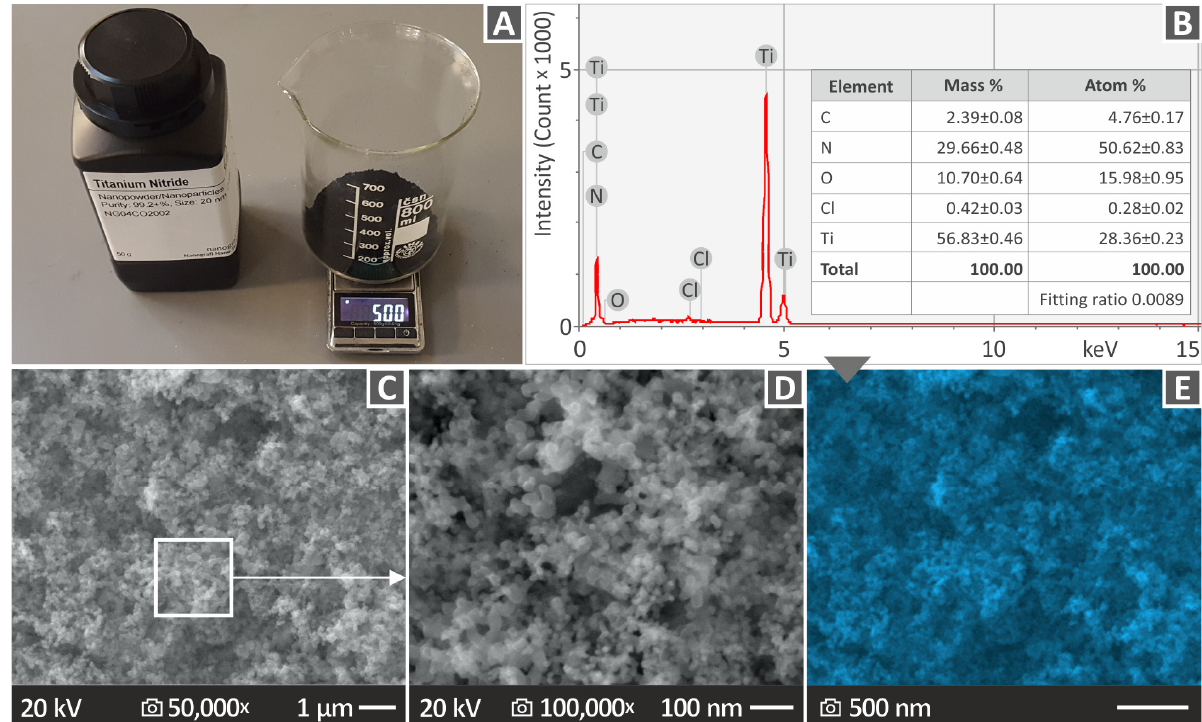
Figure 2. TiN nanopowder examination ( A ) TiN powder weight for correct wt. % concentration in the nanocomposites, ( B ) EDS graph, ( C ) 50,000× SEM image, ( D ) 100,000× SEM image, ( E ) EDS mapping for the Ti element.